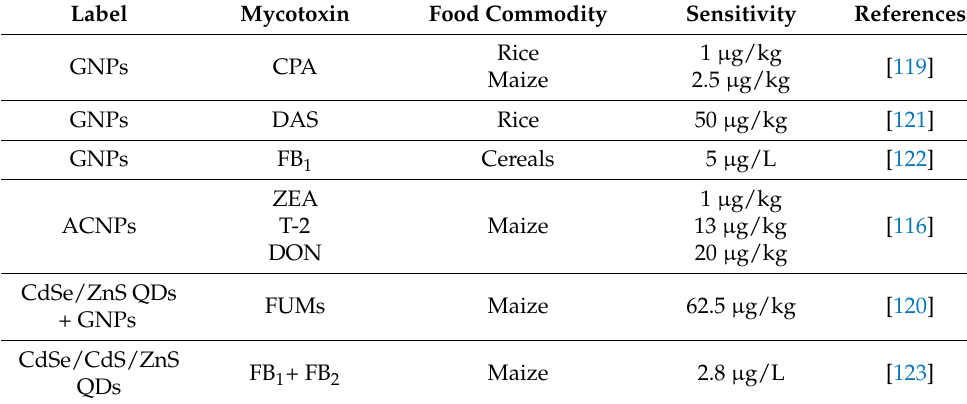
Table 4. Different labels used in mycotoxins detection and their